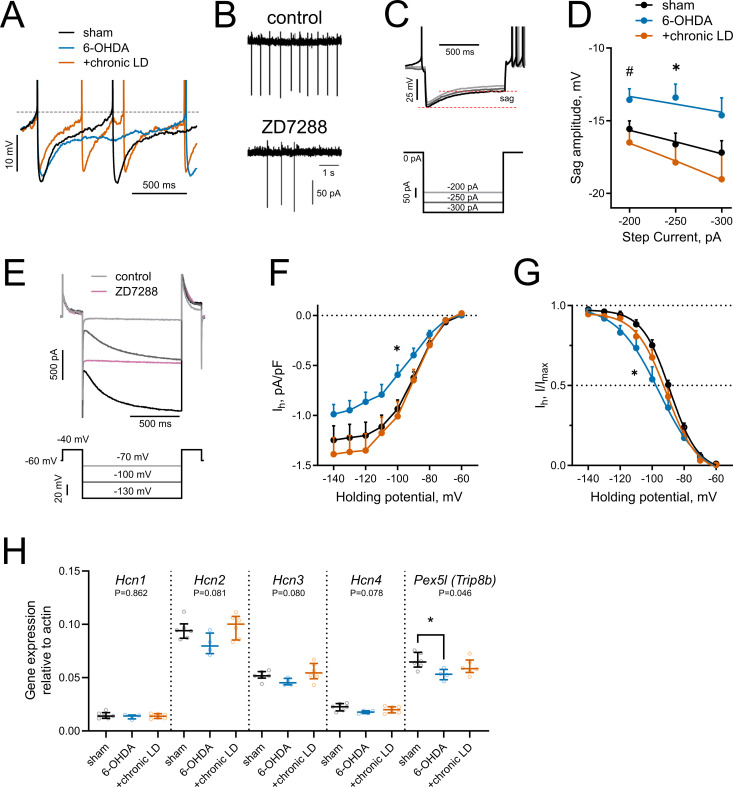
HCN-mediated currents are decreased by 6-OHDA lesion.(A) Representative perforated-patch recordings of sAP from sham, 6-OHDA and +chronic-LD groups. Dotted line represents a threshold potential, which was similar between the groups. Note the markedly slower rate of cell depolarization after the action potential in the ChIs from 6-OHDA group and decreased amplitude of the AHP in a neuron from the +chronic-LD group. (B) Representative cell-attached recordings of ChI activity before and after treatment with HCN channel blocker ZD7288 (25 µM). (C) Current-clamp protocol (lower) and representative recordings (upper) showing voltage sag, a characteristic of HCN channel activation. (D) Quantification of sag amplitude at different current steps. Sham n = 39 neurons/18 mice, 6-OHDA n = 23 neurons/11 mice, chronic-LD n = 30 neurons/12 mice; p<0.05 (*) for 6-OHDA vs. two other groups, p<0.05 (#) 6-OHDA vs. chronic-LD at indicated current by Tukey’s multiple comparisons test following repeated measures two-way ANOVA. (E) Voltage-clamp protocol (lower) and representative ZD7288-sensitive (Ih) current (upper). (F) Ih density was decreased in ChIs from DA-depleted mice. Sham n = 11 neurons/6 mice, 6-OHDA n = 12 neurons/6 mice, chronic-LD n = 13 neurons/7 mice; p<0.05 (*) for sham vs. 6-OHDA at −100 mV by Tukey’s multiple comparison following repeated measures two-way ANOVA. (G) Boltzmann fits of normalized Ih densities. (Same N as in F); p<0.05 (*) for V50 values of sham vs. 6-OHDA by Tukey’s multiple comparison following one-way ANOVA. (H) ChI-specific gene expression of Hcn1-4 isoforms and Pex5l (Trip8b) measured by RT-qPCR from striatal mRNA immunoprecipitated from Chat-Cre:Rpl22HA (ribotag) mice treated as indicated. Target mRNA levels were normalized to β-actin. Sham n = 6 samples/20 mice, 6-OHDA n = 4 samples/17 mice, chronic-LD n = 6 samples/22 mice; P-values on graphs are for Kruskal-Wallis test, p<0.05 (*) with Dunn’s multiple comparisons test.Figure 3—source data 1.Individual neuron data and statistics for all panels.